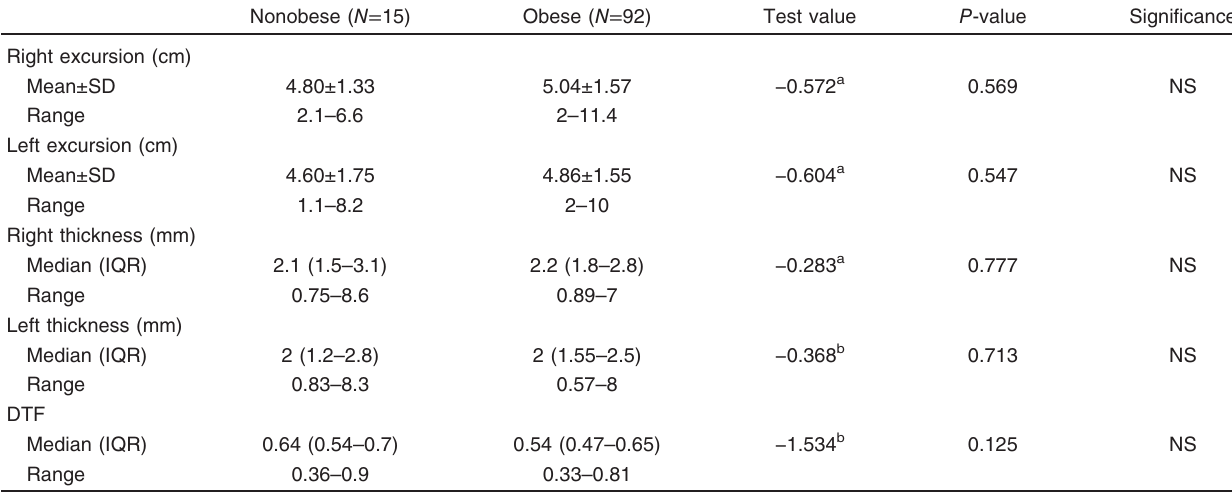
Table 6 Comparison between the obese and nonobese as regards ultrasonographic diaphragmatic indices Nonobese ( N = 15)